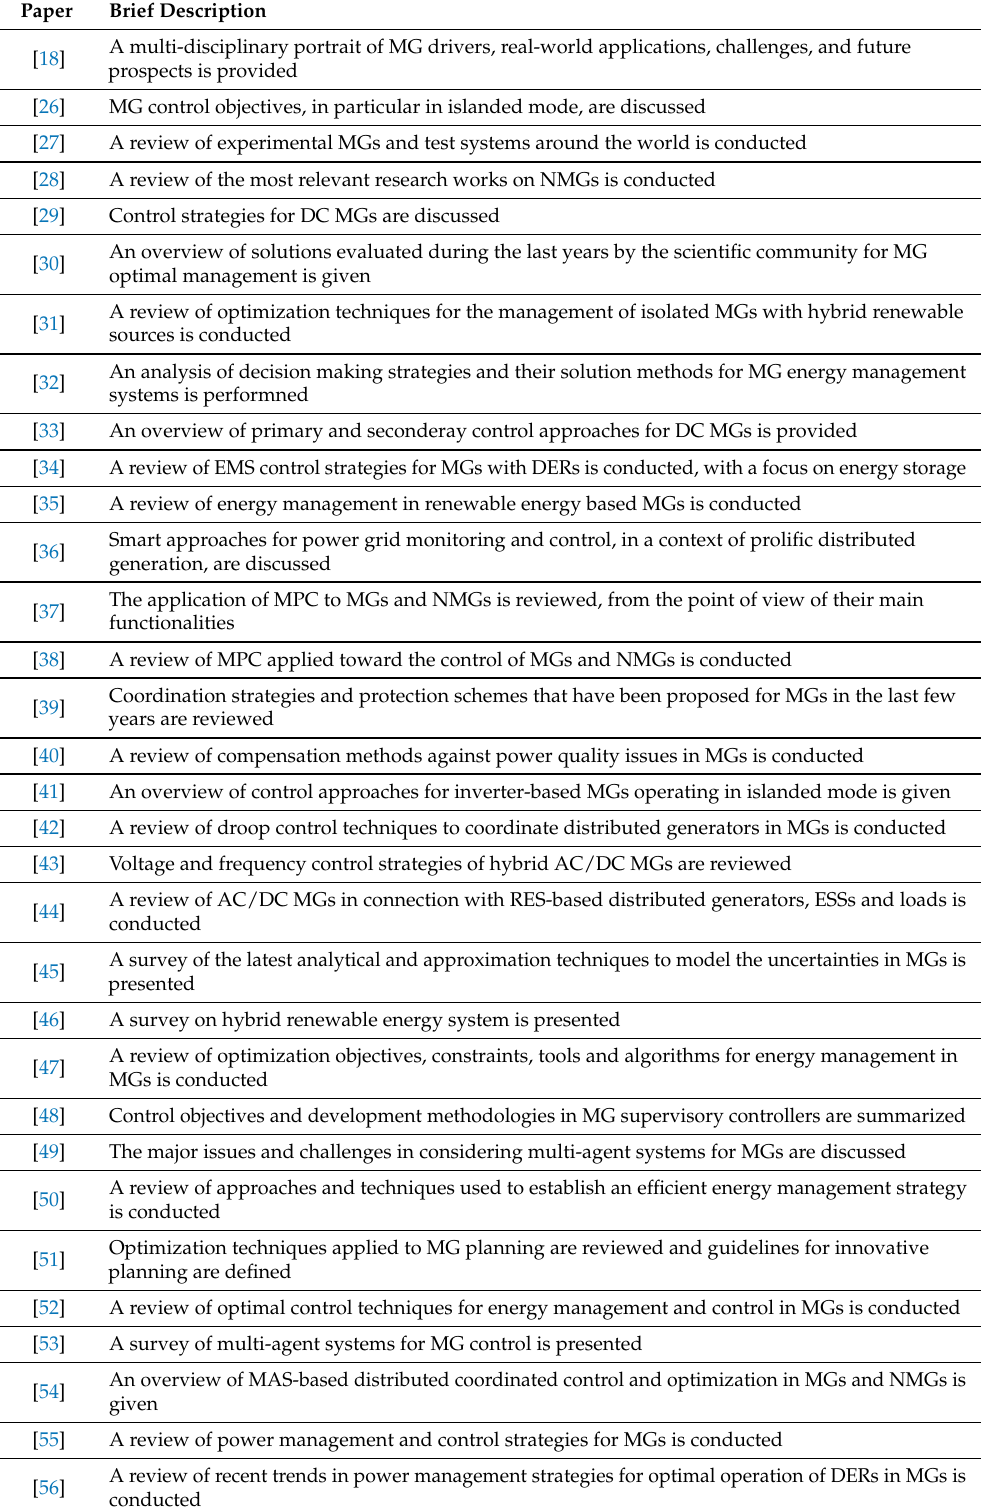
Table 1. Review papers. AC stands for alternative current. DC stands for direct current. DER stands for distributed energy resource. EMS stands for energy management system. EV stands for electric vehicle. MAS stands for multi-agent system. MG stands for microgrid. MPC stands for model-based predictive control. NMG stands for networked microgrid. RES stands for renewable energy